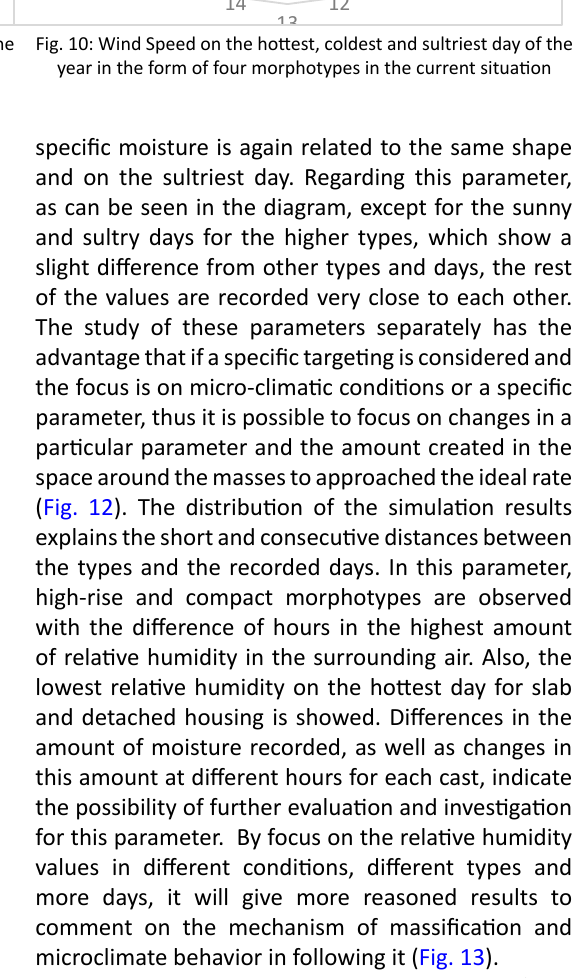
Fig. 9: Air temperature on the hottest, coldest and sultriest day of the year in the form of four morphotypes in the current situation